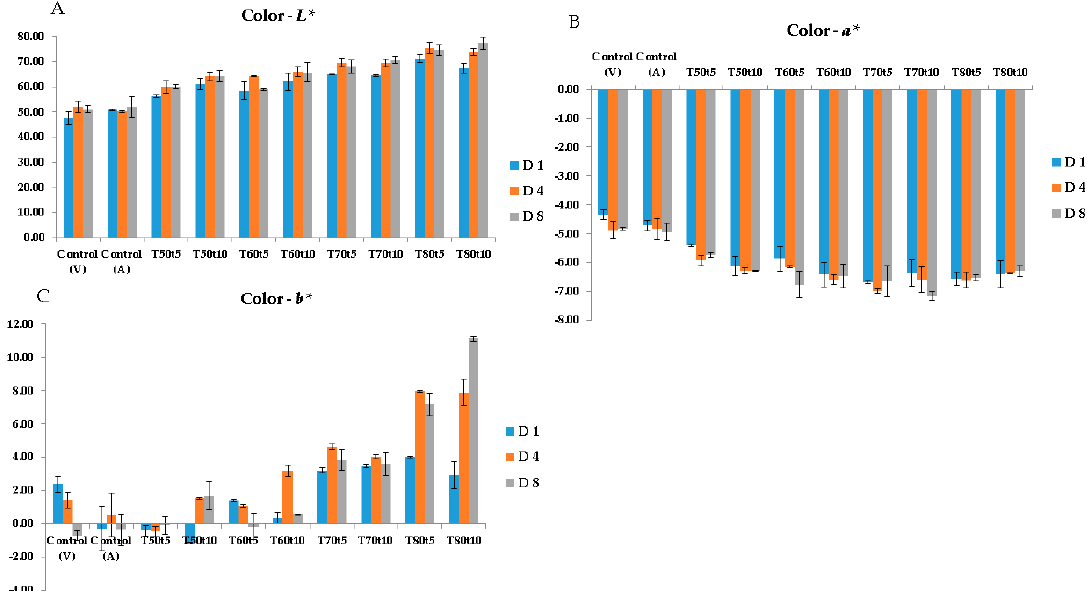
Figure 3. Color parameters: lightness ( A ), redness ( B ), and yellowness ( C ), obtained on the cod samples as a function of cooking temperature; T, cooking time; t, and storage days; D (V; vacuum-packed samples, A; air-packed samples).